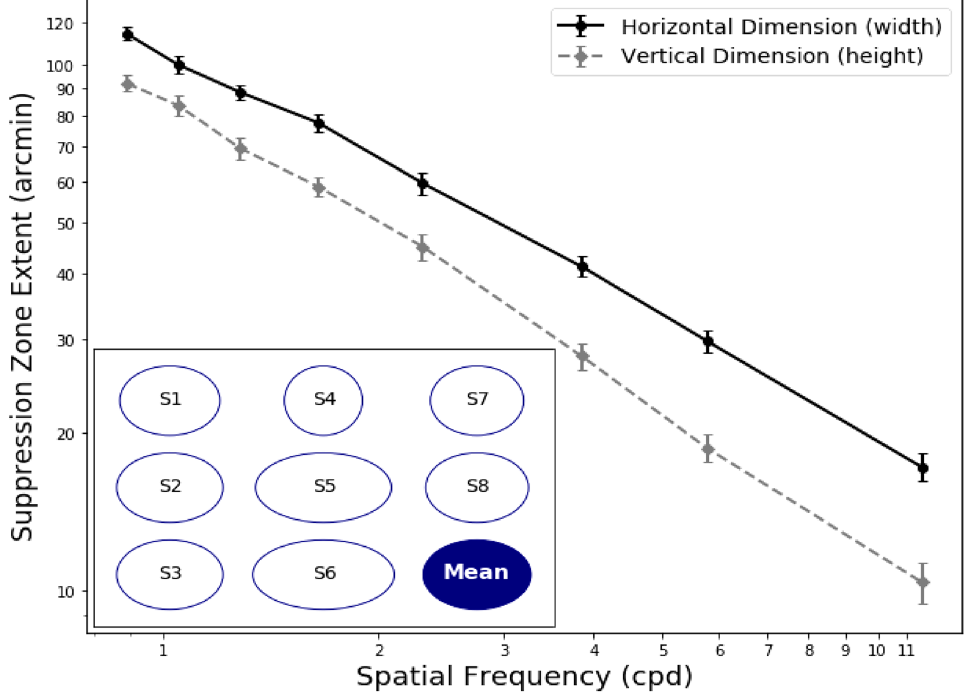
Figure 4. This plot shows the width and height of the suppression zones across all the spatial frequencies. The width was larger by approximately 1.4 × than the height, suggesting that the suppression zone is elliptical in shape. The schematic on the lower left shows the ratio of width to height for each subject. The mean area of suppression is elliptical in shape (dark blue). Standard errors are shown on the vertical bars.